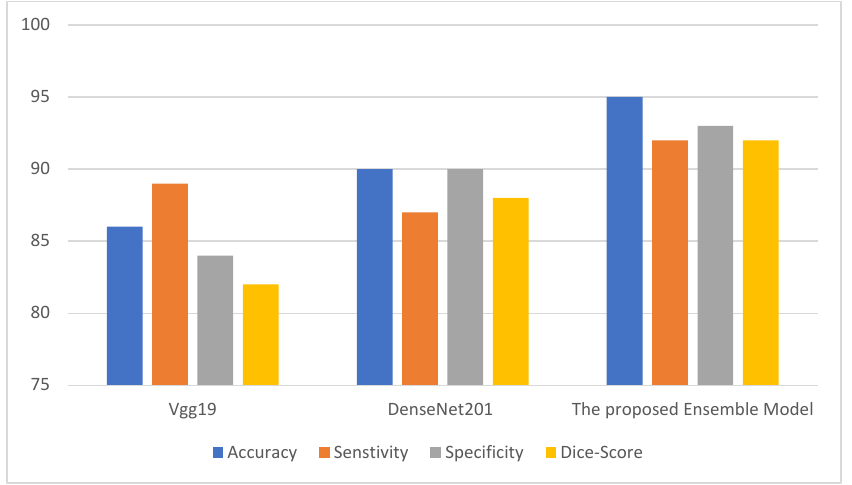
Figure 2. The performance of Vgg19, DenseNet201, and the ensemble models for the Facemg database.